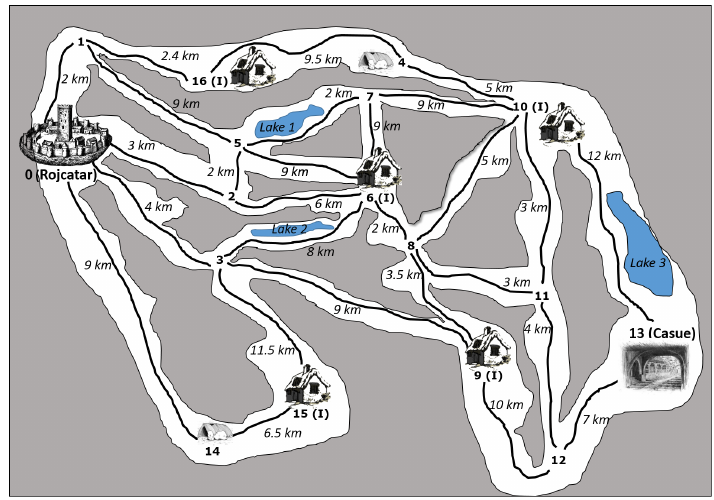
Figure 2. Map of the region of Al-Bufera.